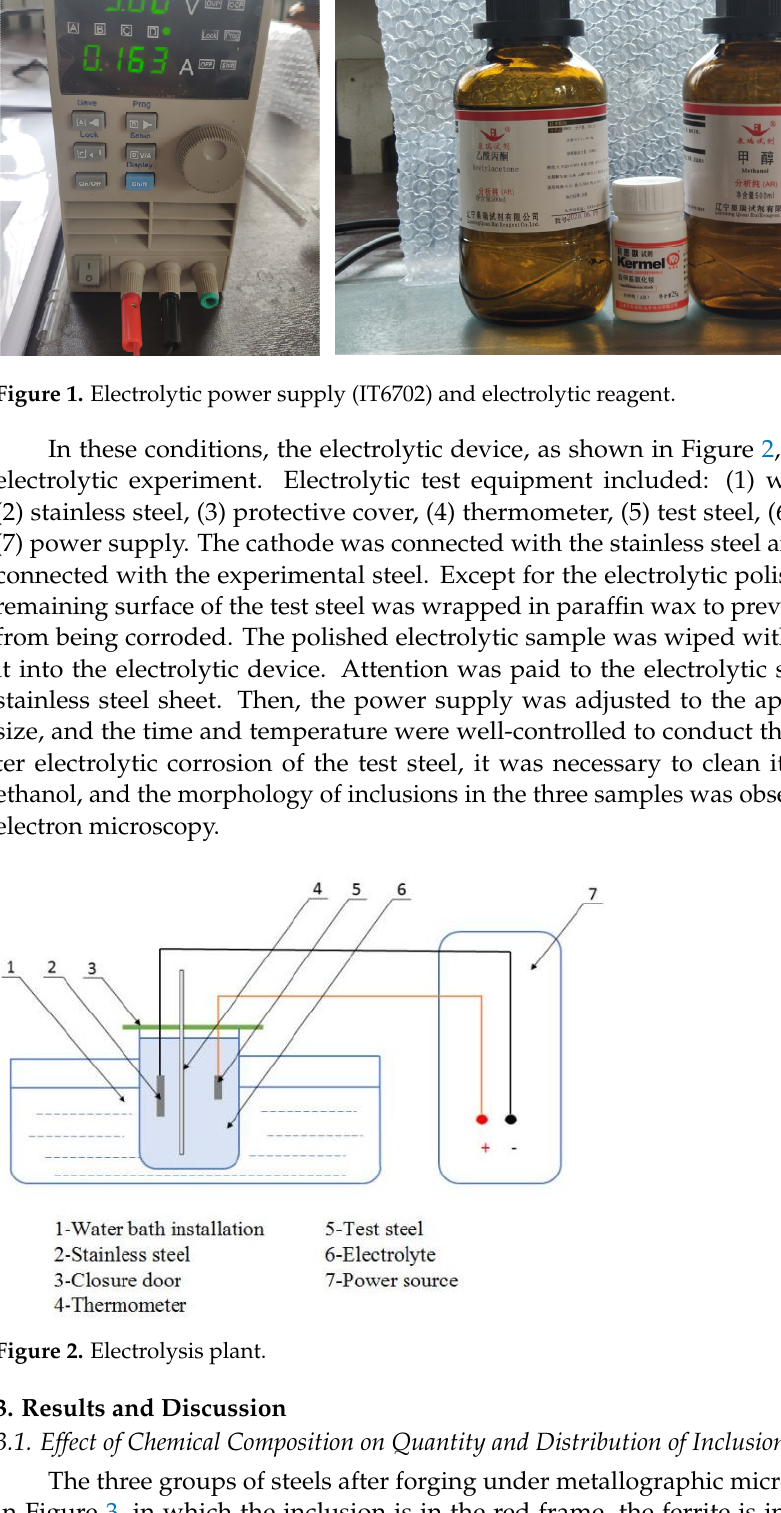
Figure 1. Electrolytic power supply (IT6702) and electrolytic reagent.